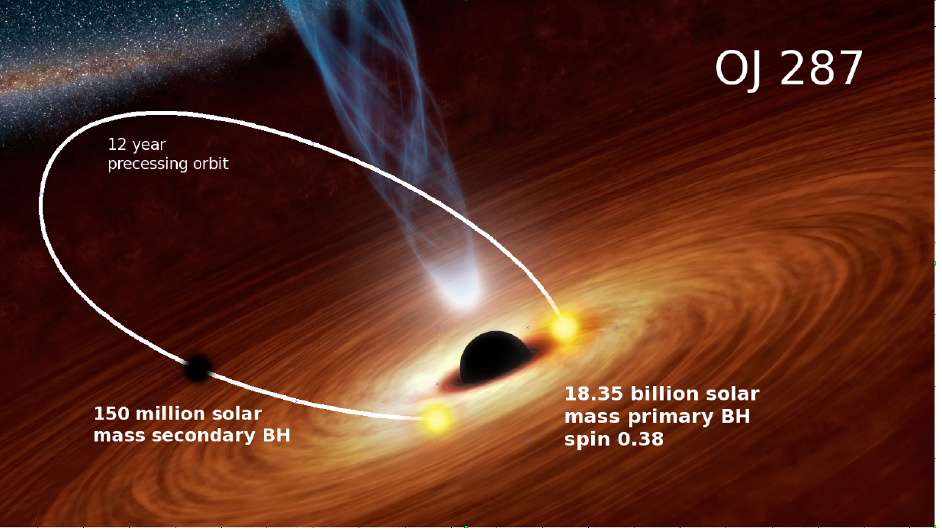
Figure 2. Artistic illustration of the binary black hole system in OJ 287 [9]. ©AAS